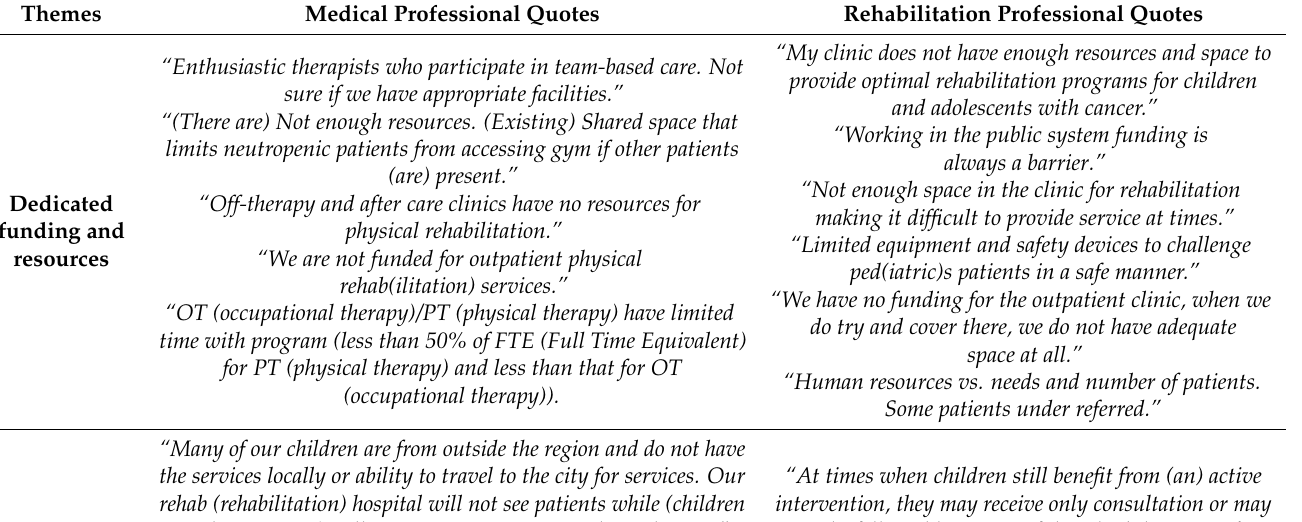
Table 5. Thematic findings and representative